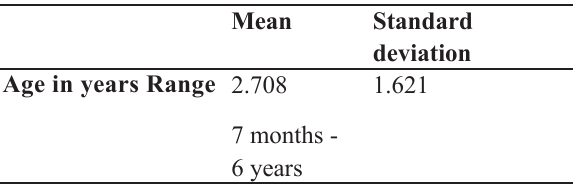
Table 2. Demography presentation of subjects (N=12) Number of